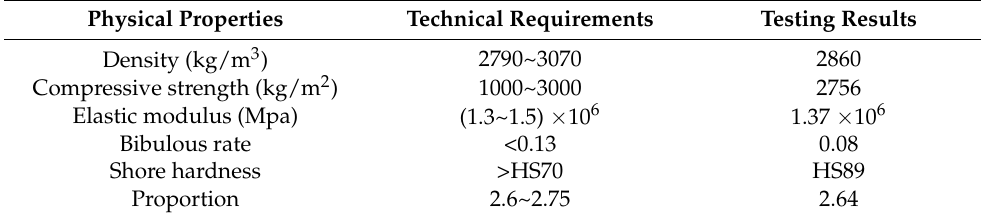
Figure 2. The granite specimen. Table 4. Properties of the granite.